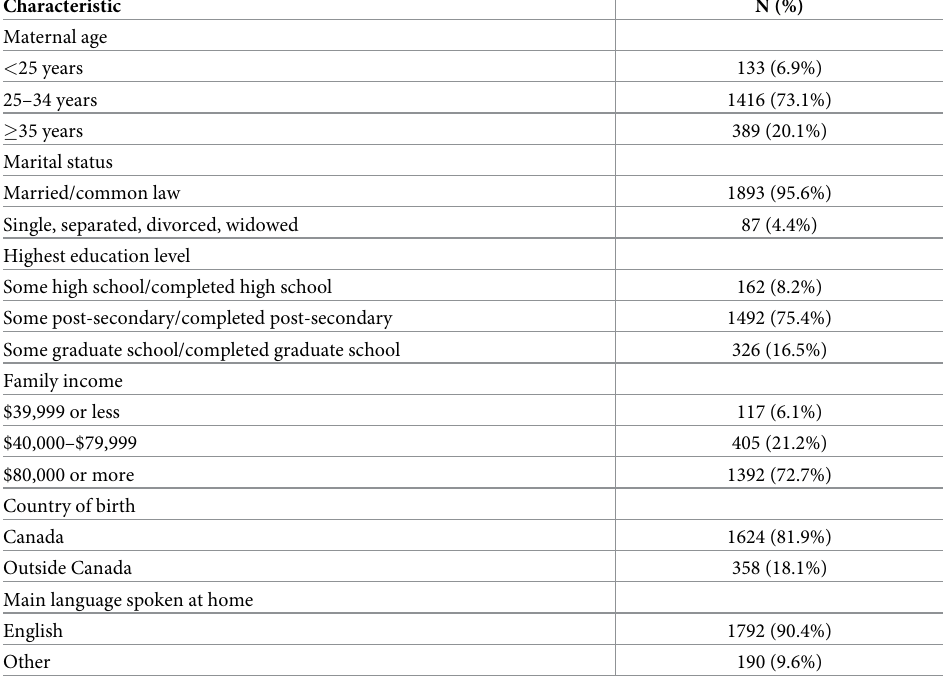
Table 1. Participant characteristics (n =